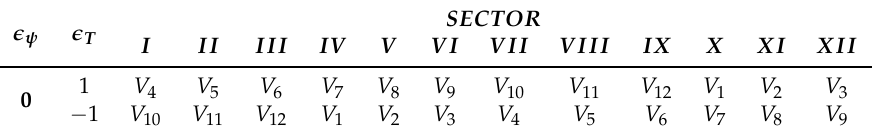
Table 1. Look-up table for a DTC-2+3P, without flux control.